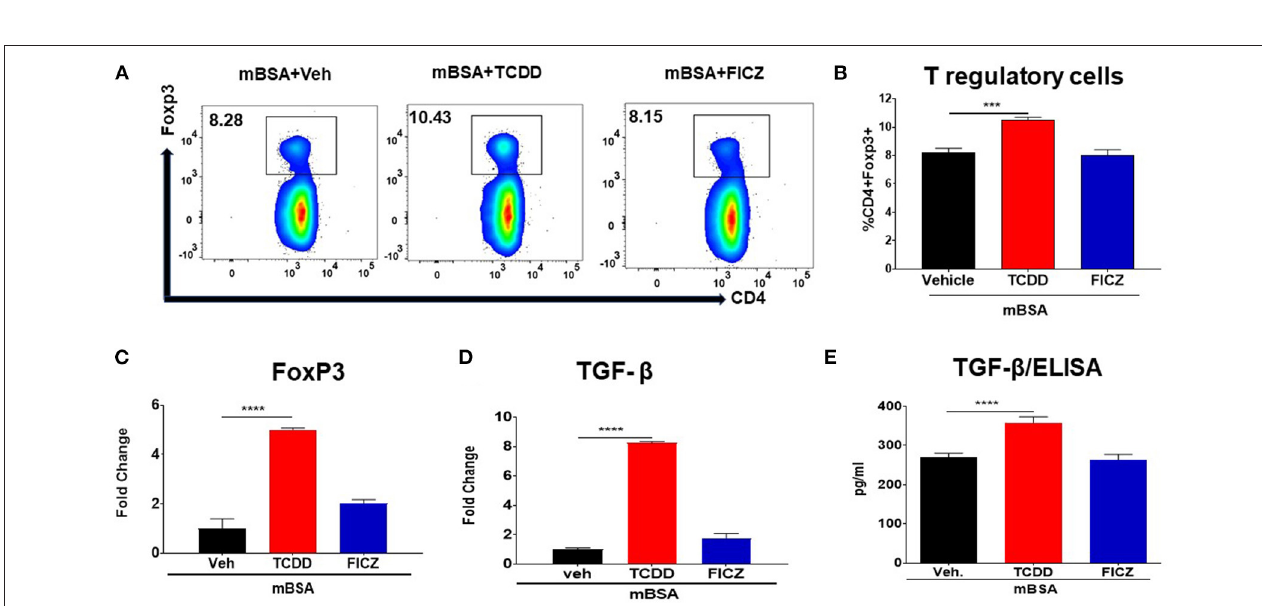
FIGURE 3 | TCDD induces FoxP3 + Tregs during DTH response. DTH was induced as described in Figure 1 legend. Tregs, as well as expression of FoxP3 and TGF- β , were studied. (A) Representative plots from FlowJo software analysis of flow cytometry data showing CD4 + Foxp3 + cells from DLNs. (B) Percentage of CD4 + Foxp3 + cells from groups of 5 mice. (C) qRT-PCR validation of mRNA expression of Foxp3 in DLN cells. (D) qRT-PCR based mRNA expression of TGF- β in DLN cells. (E) DLN cells were plated overnight in complete media and culture supernatants were harvested and subjected to ELISA for TGF- β . The statistically significant differences between the groups were calculated using one-way ANOVA. Vertical bars represent Mean ± SEM and significant differences between groups are shown with asterisks (*** p < 0.001, **** p < 0.0001).